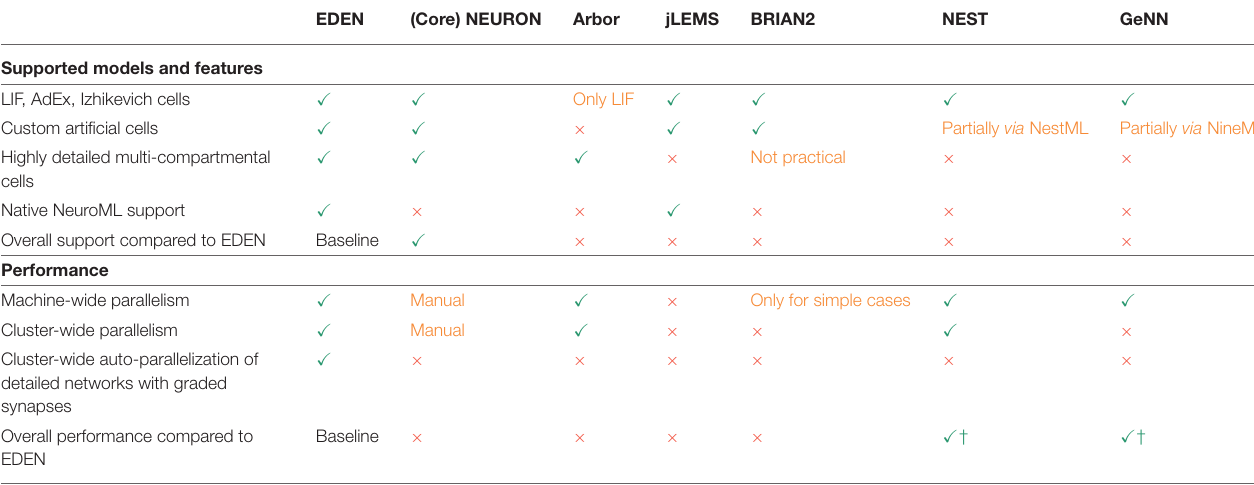
TABLE 1 | Qualitative comparison between EDEN and other state-of-the-art neural simulators: NEURON (McDougal et al., 2017), CoreNEURON (Kumbhar et al., 2019), JLEMS (Cannon et al., 2014), BRIAN2 (Stimberg et al., 2019), GeNN (Yavuz et al., 2016), NEST (Gewaltig and Diesmann, 2007), and Arbor (Akar et al., 2019). EDEN (Core) NEURON Arbor jLEMS BRIAN2 NEST GeNN